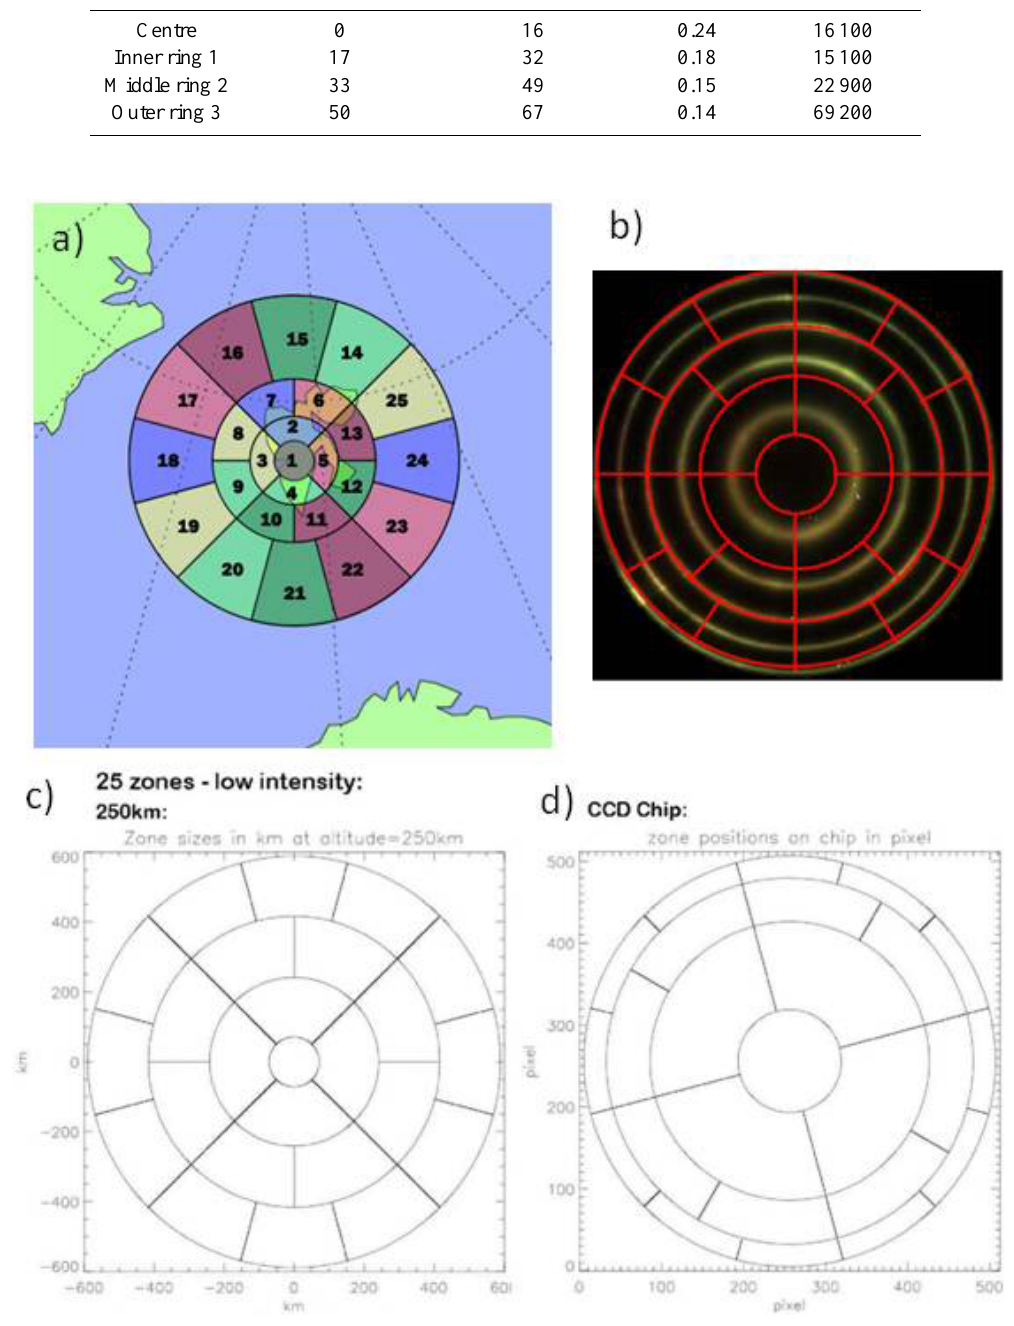
Fig. 4. Illustration of the SCANDI zones. For the first winter 2006–2007 (a) projection of the zones onto an altitude of 250km when the zones were divided evenly on the CCD chip, as shown by (b) . Here also is shown the Airy function image. From winter 2007–2008 onwards the zones were set to produce an equi-area projection on the sky (c) , and (d) shows the projection on the CCD